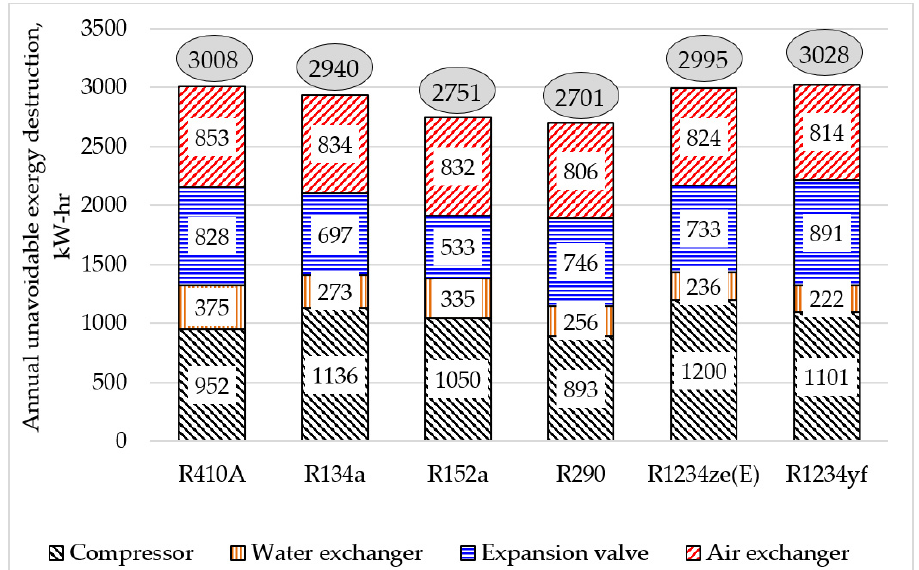
Figure 4. Values of unavoidable exergy destruction E UN , yr tigated heat pump with different working fluids.